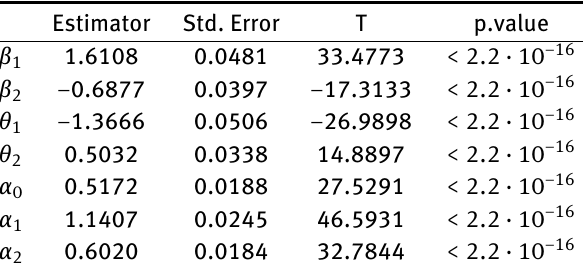
Table 1: Estimator values and standard deviations of estimators.